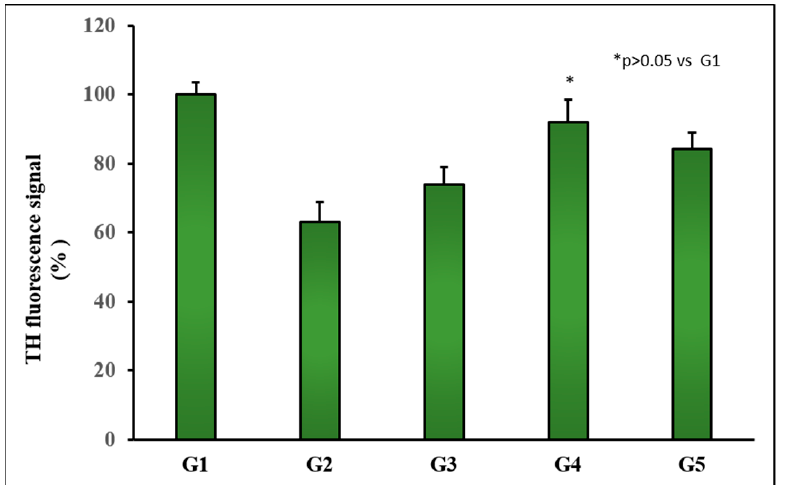
Figure 6. Representative TH fluorescence signal in coronal brain slices at the level of the substantia nigra for all animal groups. Control group (G1); RT-treated control group (G2); RT-treated animals also receiving formulation MP-TC4 (G3), formulation NP-TC3 (G4), and TC in saline (G5). TH (tyrosine hydroxylase), RT (rotenone), TC (tolcapone).